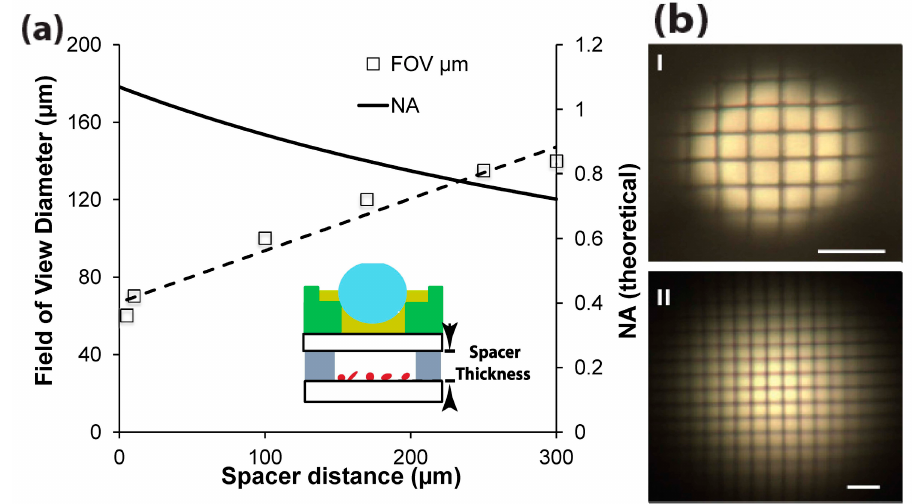
Figure 8. ( a ) Field of view (FOV) and NA versus spacer thickness. The theoretical NA values were calculated from thick-lens equation (see supplementary). ( b ) Image of 10 µm grid using a 5 µm spacer ( I ) and a 250 thick µm spacer ( II ). Scale bar: 20 µm in ( b